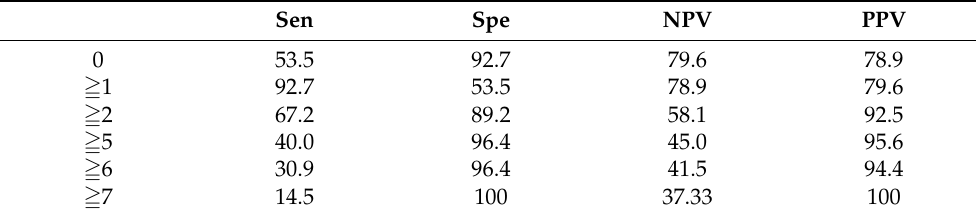
Table 3. Sensitivity, specificity, NPV, and PVV of a predictive score for ischemic ovarian torsion. Sen